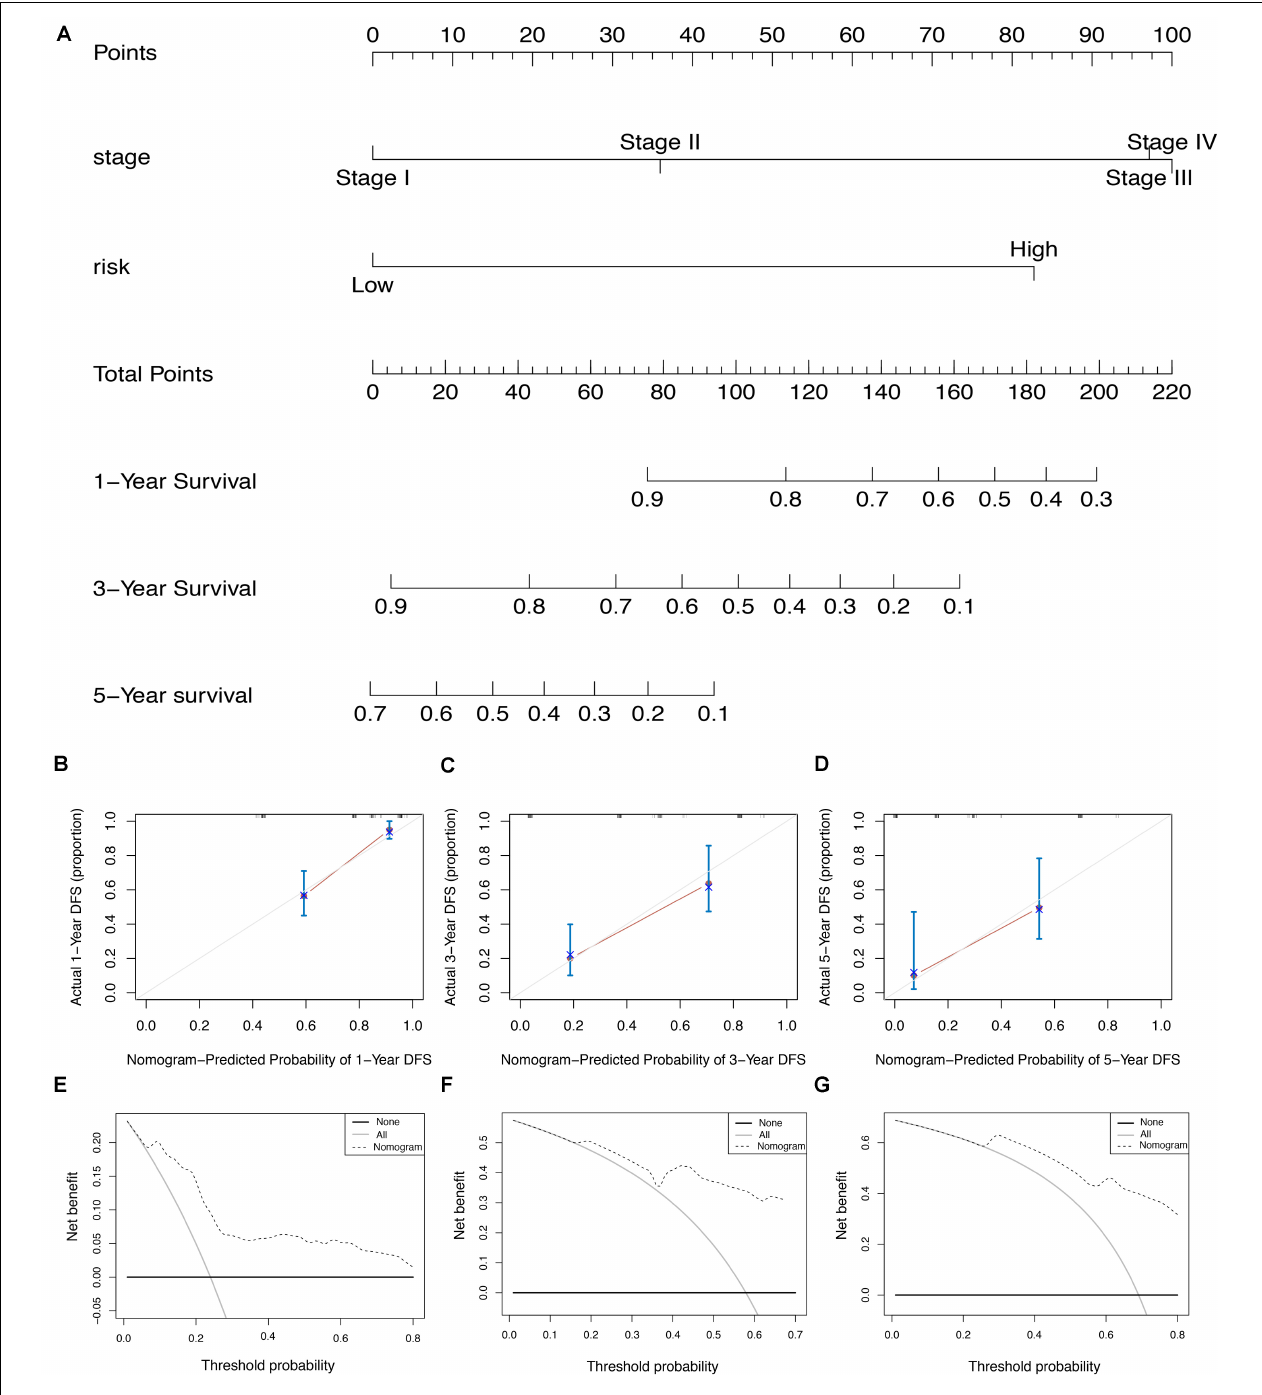
FIGURE 9 | The AS-clinicopathologic nomogram for prediction on survival probability in patients with ESCA. (A) Development of AS-clinicopathologic nomogram for predicting 1-, 3-, and 5-years OS for ESCA patients. (B–D) Calibration plot of the AS-clinicopathologic nomogram in terms of agreement between nomogram-predicted and observed 1-, 3-, and 5-years outcomes in the ESCA cohort. The actual performances of our model are shown in red lines. And the silver line of 45 ◦ represents the ideal performance. (E–G) Decision curve analyses of the AS-clinicopathologic nomogram for 1-, 3-, and 5-years risk in ESCA cohort. The gray line represents the net benefit of treat-all scheme varying with threshold probability, while the black line represents the net benefit of treat-no scheme. The net benefits by using our nomogram for predicting 1-, 3-, and 5-years OS are displayed with imaginary line.